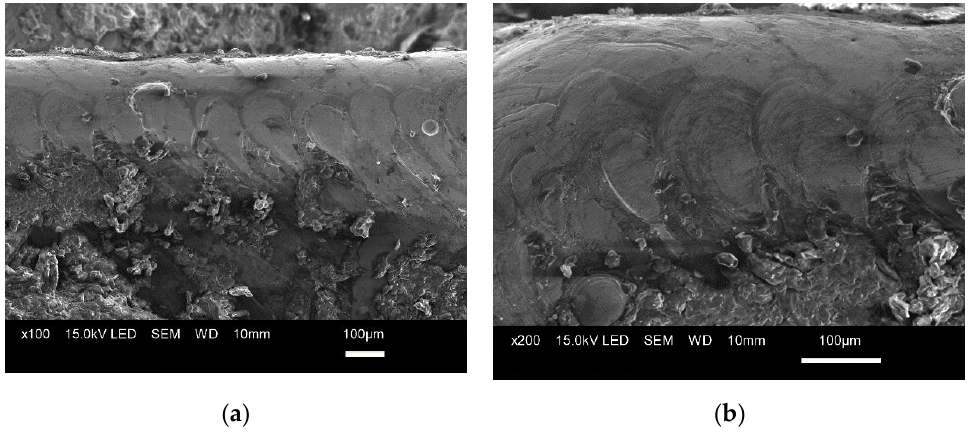
Figure 13. Tool structure magnified ( a ) 100×, ( b ) 200×.